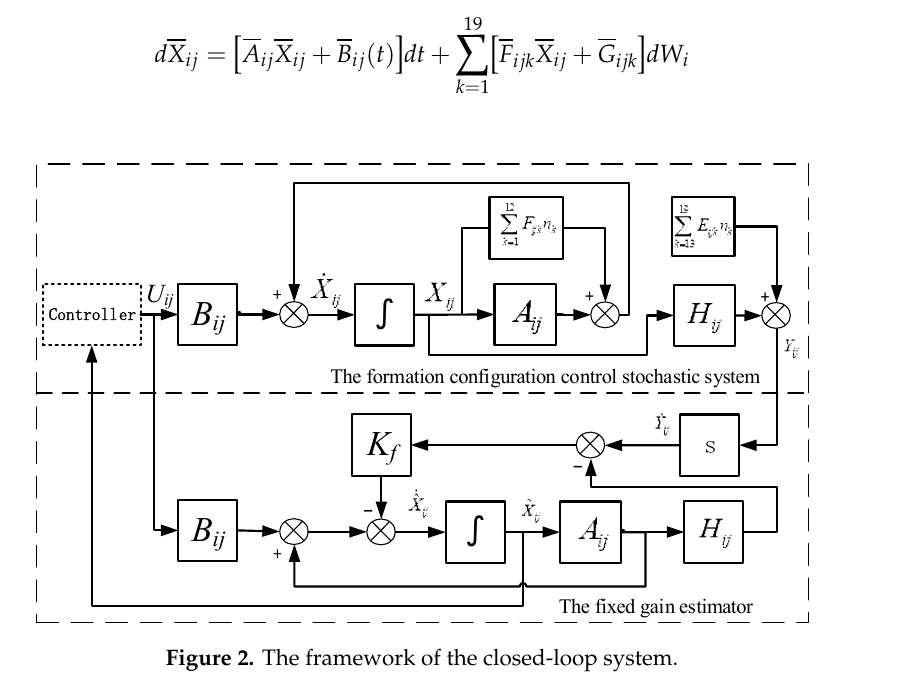
Figure 2. The framework of the closed-loop system.